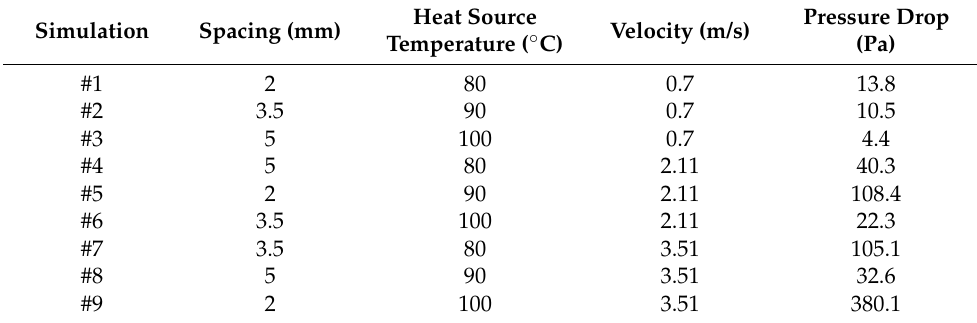
Table 5. Correlation between pressure drop and DOE factors.